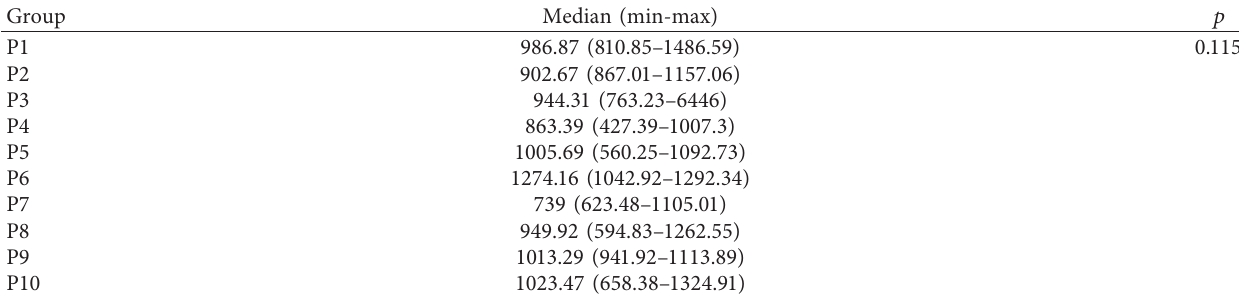
Table 6: The differences in collagen thickness in micrometer assessed using the Kruskal–Wallis test.